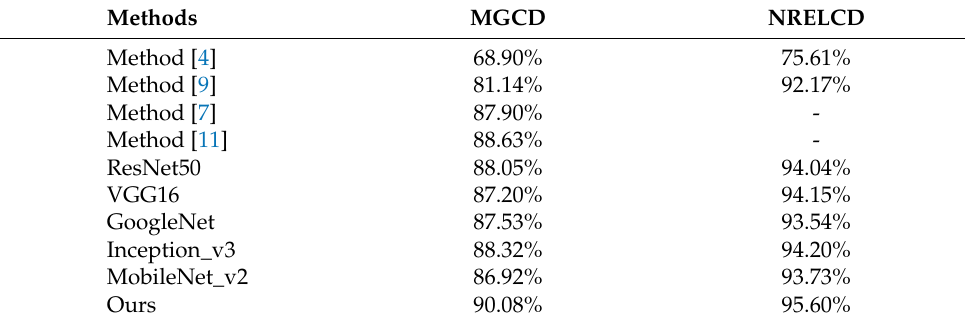
Table 4. Comparative experiment of classification